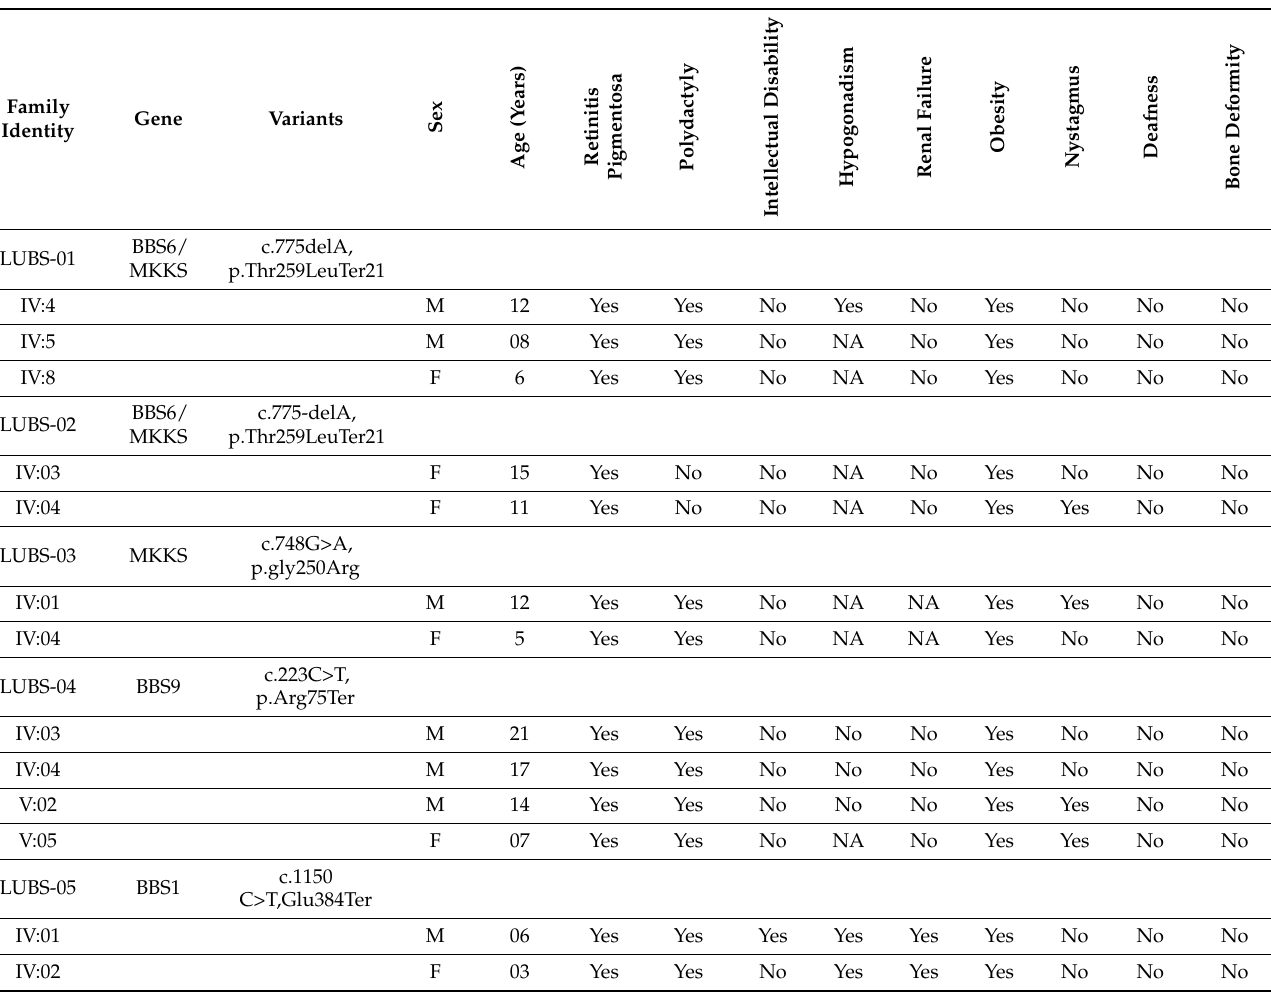
Table 1. Clinical findings of the families affected with Bardet biedl